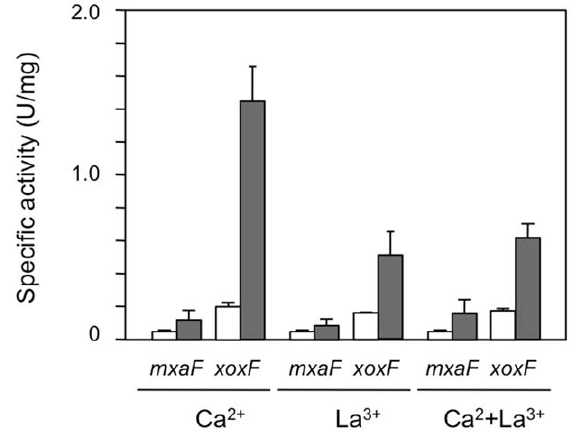
Figure 3. Expression of mxaF-xylE and xoxF1-xylE promoter fusions in M.extorquens strain AM1. The mxaF and xoxF1 promoter activities were determined by measuring catechol 2,3-dioxygenase activity (XylE) in crude cell extracts of strains grown in methanol (black bar) or succinate (white bar) media containing 30 m M La 3 + and/or Ca 2 + . Results are shown as means with standard deviations ( n